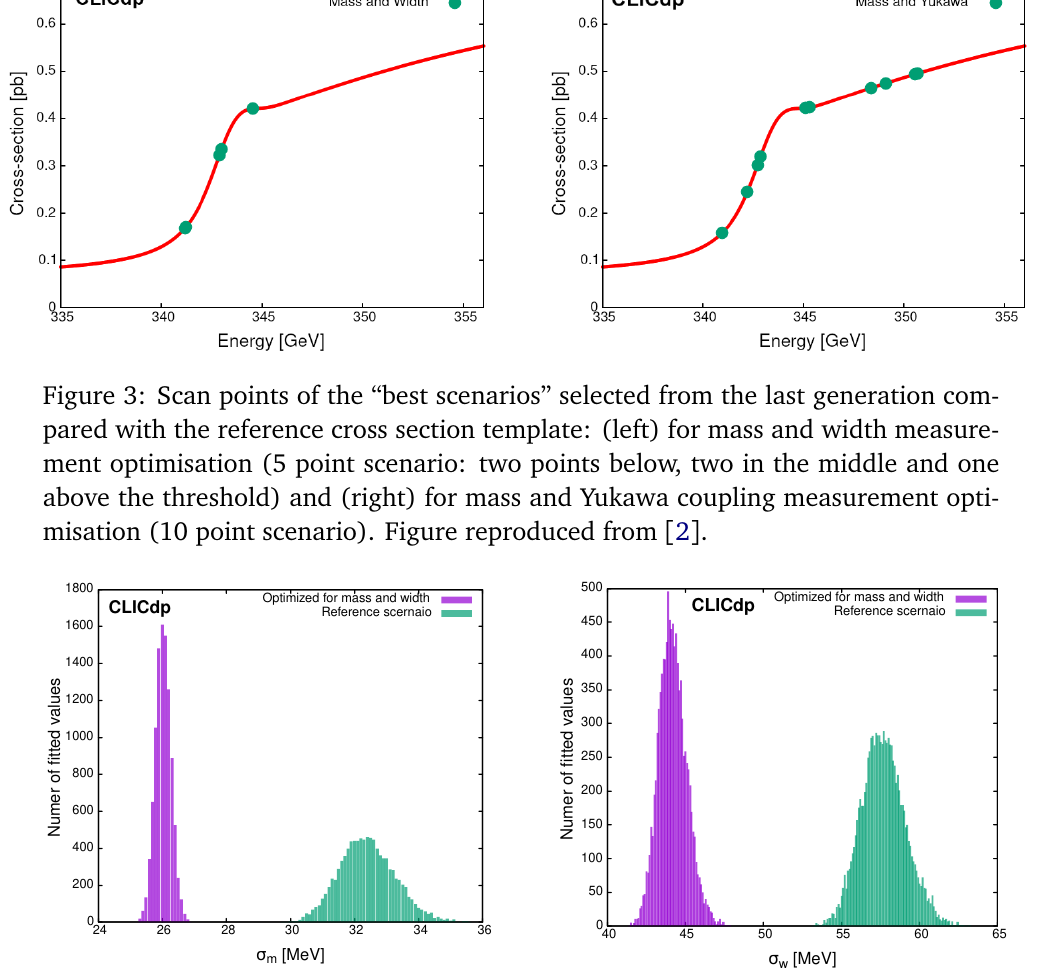
Figure 4: Mass (left) and width (right) uncertainty distributions in scenario opti- mised for mass and width measurement (see Fig. 3), collated with the the reference scenario’s distributions. Figure reproduced from [ 2 ]